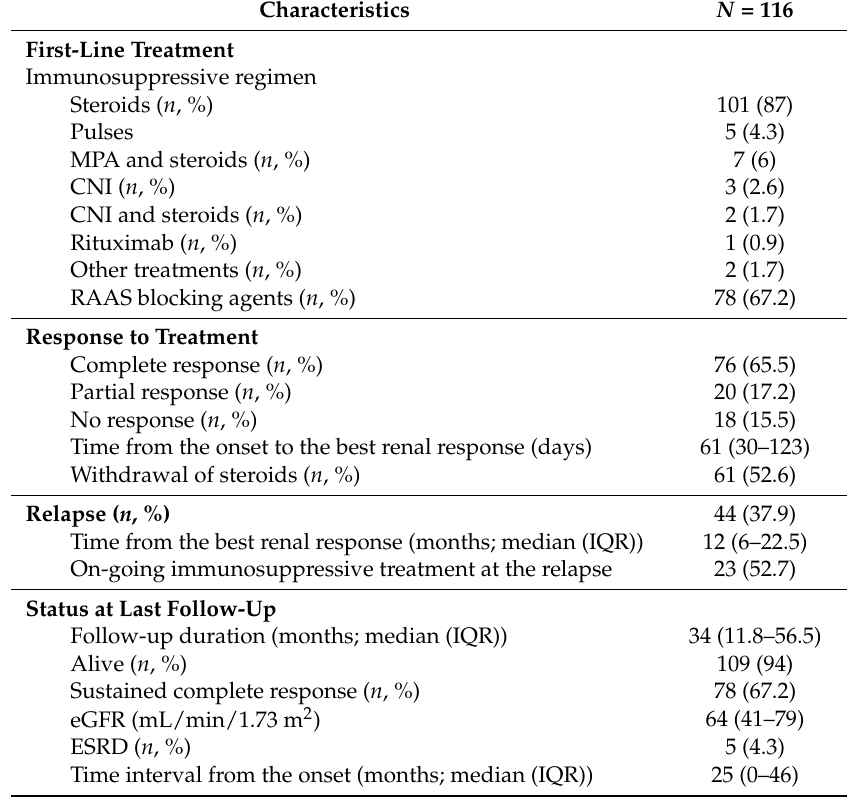
Table 2. Treatments and Outcomes. MMF, mycophenolate mofetil; CNI, calcineurin inhibitors; RAAS, renin-angiotensin-aldosterone system; IQR, interquartile ranges; eGFR, estimated glomerular filtration rate; ESRD, end-stage renal